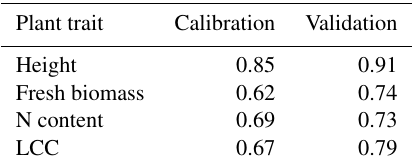
Table 3. Correlation coefficients ( r ) based on a linear regression be- tween average plot height derived from the crop surface model and each selected plant trait for the calibration ( n = 28) and validation set ( n = 28). LCC: leaf chlorophyll